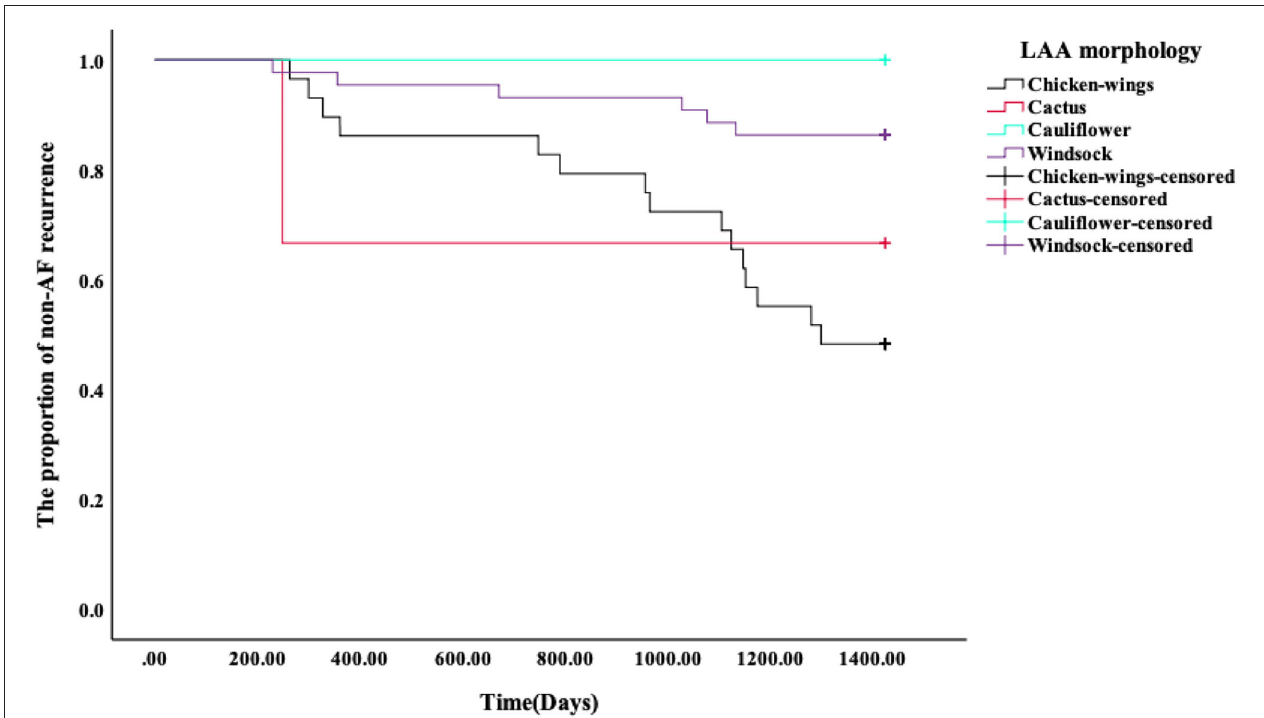
FIGURE 4 | Kaplan–Meier analysis for recurrence after RFA. The Kaplan–Meier survival curves of AF recurrence after ablation and the log-rank test between the four types’ LAA morphology during 1,460 days of